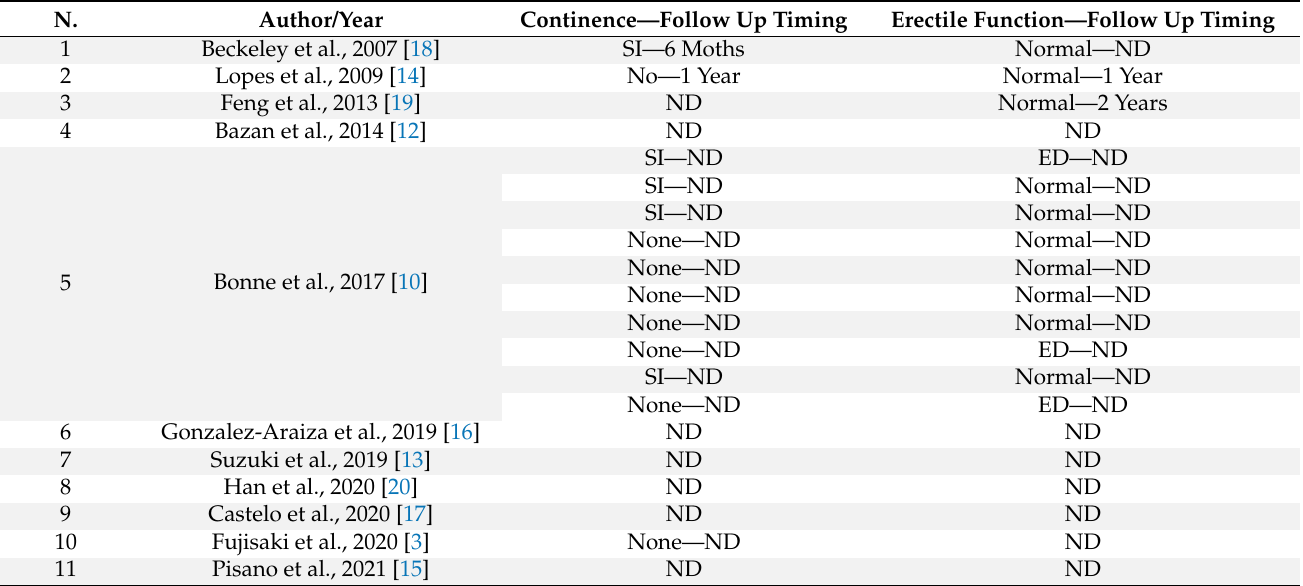
Table 3. Summary of the works reviewed. Functional data of the patients analyzed: continence and erectile function. SI = stress incontinence ; ND = not described ; ED = erectile disfunction .